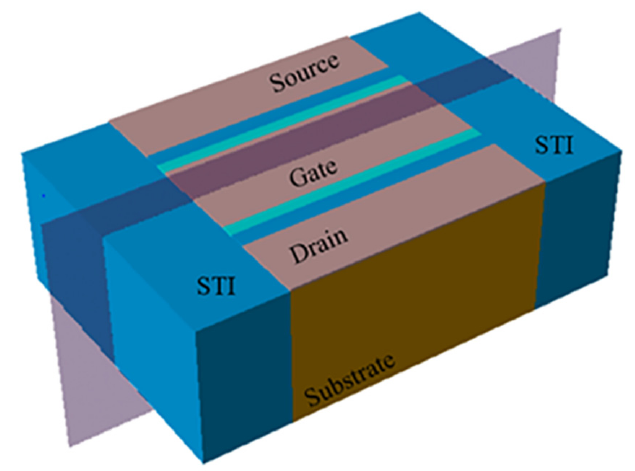
Figure 11. MOSFET simulation structure.